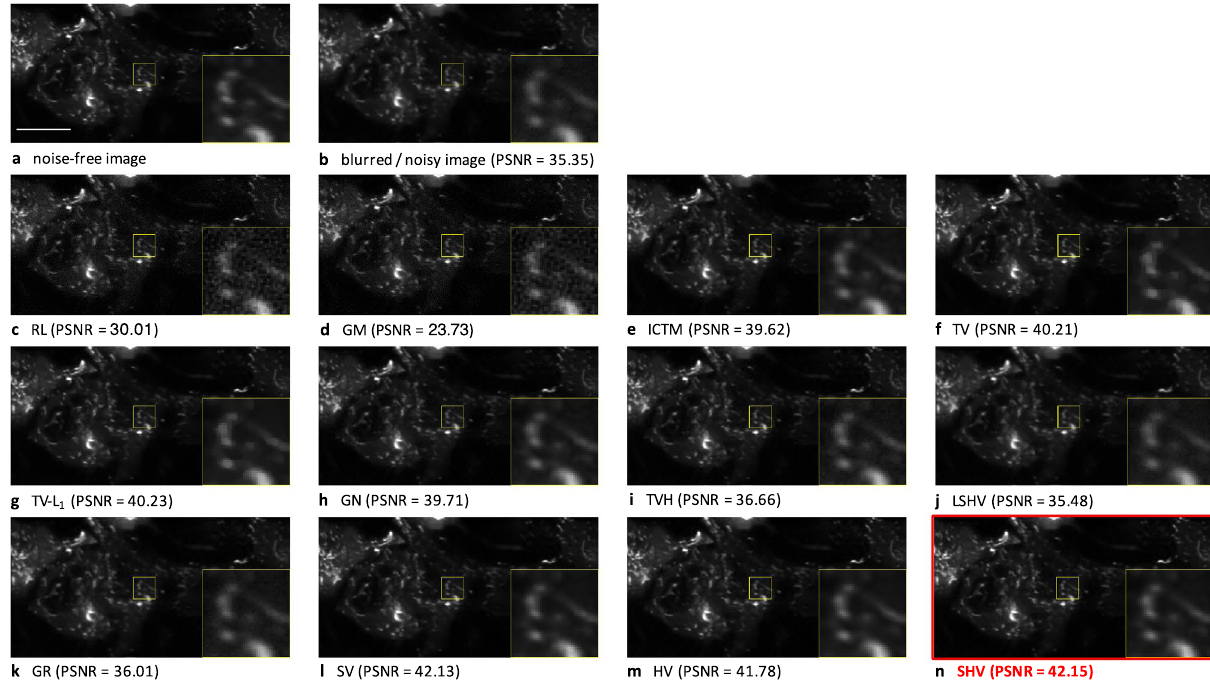
Figure 5. Deconvolution of a confocal microscopy image with different methods. ( a ) The original 512 × 256 pixels image (Image #1) (source: CNRS UMR144 Institut Curie) is a single 2D plane extracted from a 77 time frame series depicting Rab11a-mCherry protein in M10 cells, was previously acquired in line scanning confocal microscopy. Scale bar: 10 µ m. ( b ) Artificially corrupted image by a Gaussian PSF σ xy = 1.0 pixel and Gaussian white noise with standard deviation τ = 0.01 ( b ). ( c ) Image deconvolved with the Richardson-Lucy (RL) 3 algorithm. ( d ) Image deconvolved with the Gold-Meinel (GM) 39 algorithm. ( e ) Image deconvolved with the iterative constrained Tikhonov-Miller (ICTM) 9 algorithm. ( f ) Image deconvolved with the Total Variation (TV) 40 regularizer. ( g ) Image deconvolved with the Total-Variation-L1 (TV-L1) 21 . ( h ) Image deconvolved with the GraphNet (GN) 17 regularizer. ( i ) Image deconvolved with the Total Variation-Huber (TVH) 41 regularizer. ( j ) Image deconvolved with the Log Sparse Hessian Variation (LSHV) 16 regularizer. ( k ) Image deconvolved with the Good’s roughness (GR) 42 regularizer. ( l ) Image deconvolved with the Sparse Variation (SV) 20 regularizer. ( m ) Image deconvolved with the Hessian Variation (HV) 14,15 regularizer. ( n ) Image deconvolved with the Sparse Hessian Variation (SHV) (our SPITFIR(e) method) regularizer (black box). Zoom-in views are displayed in yellow windows for comparison in